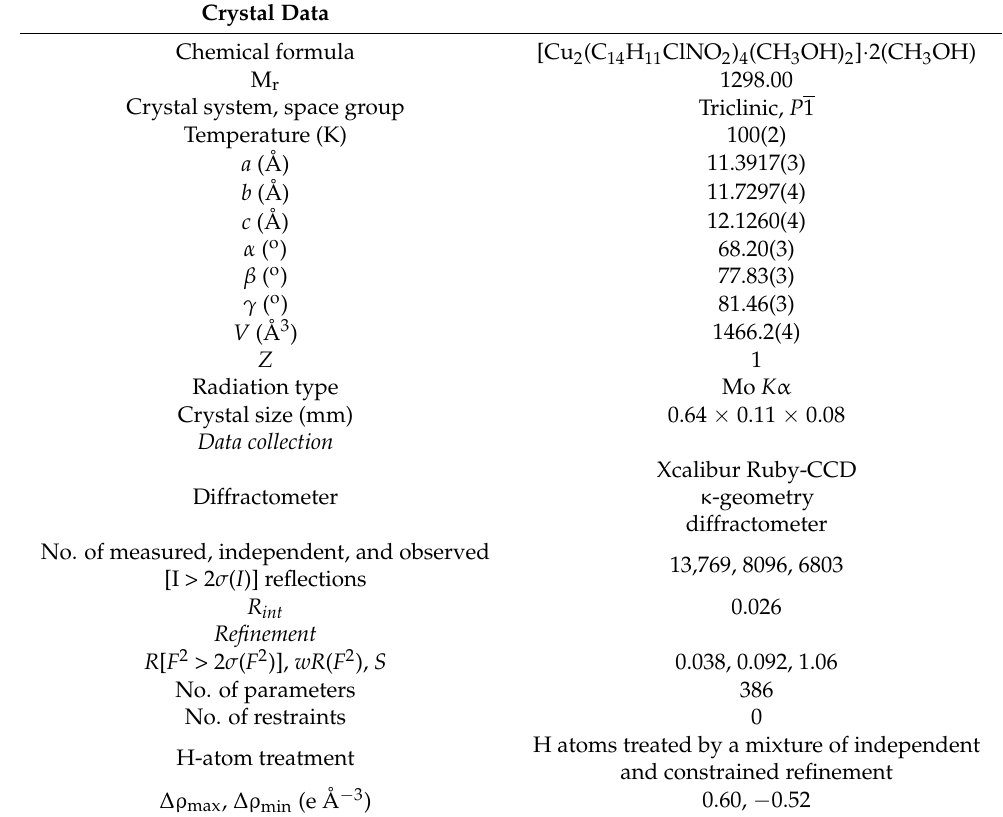
Table 1. Crystallographic data and refinement parameters for [Cu II 2 (Tolf) 4 (MeOH) 2 ] ·